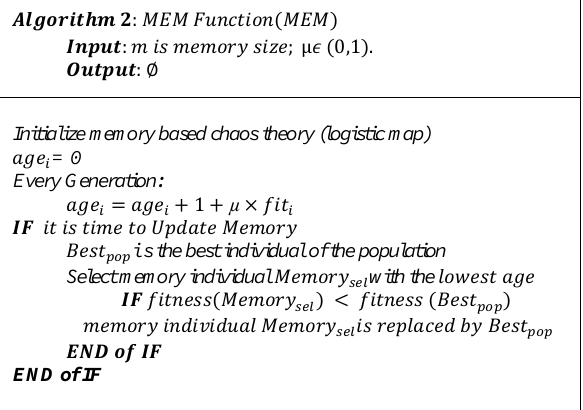
Figure 4. Pseudo-code for update memory.